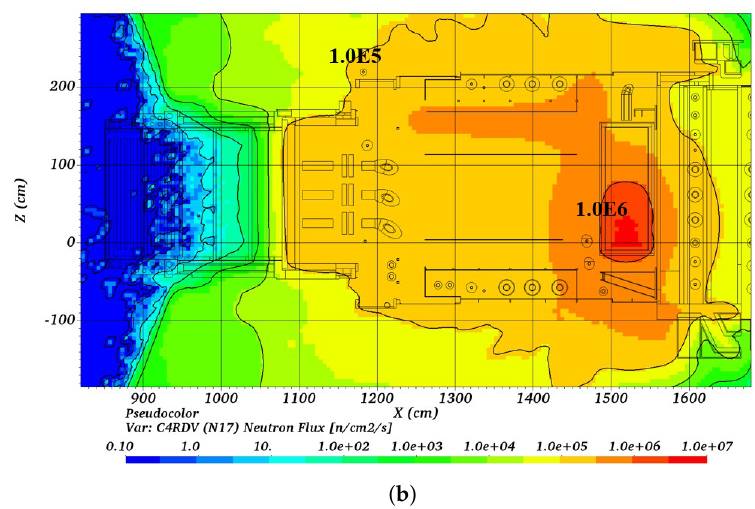
Figure 13. ( a ) C4RDV 17 N total neutron flux [n/cm 2 /s] in PI and ( b ) through the delay tank.